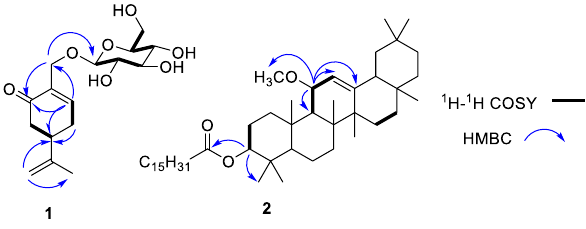
Fig. 2 Key 1 H– 1 H COSY and HMBC correlations of compounds 1 and